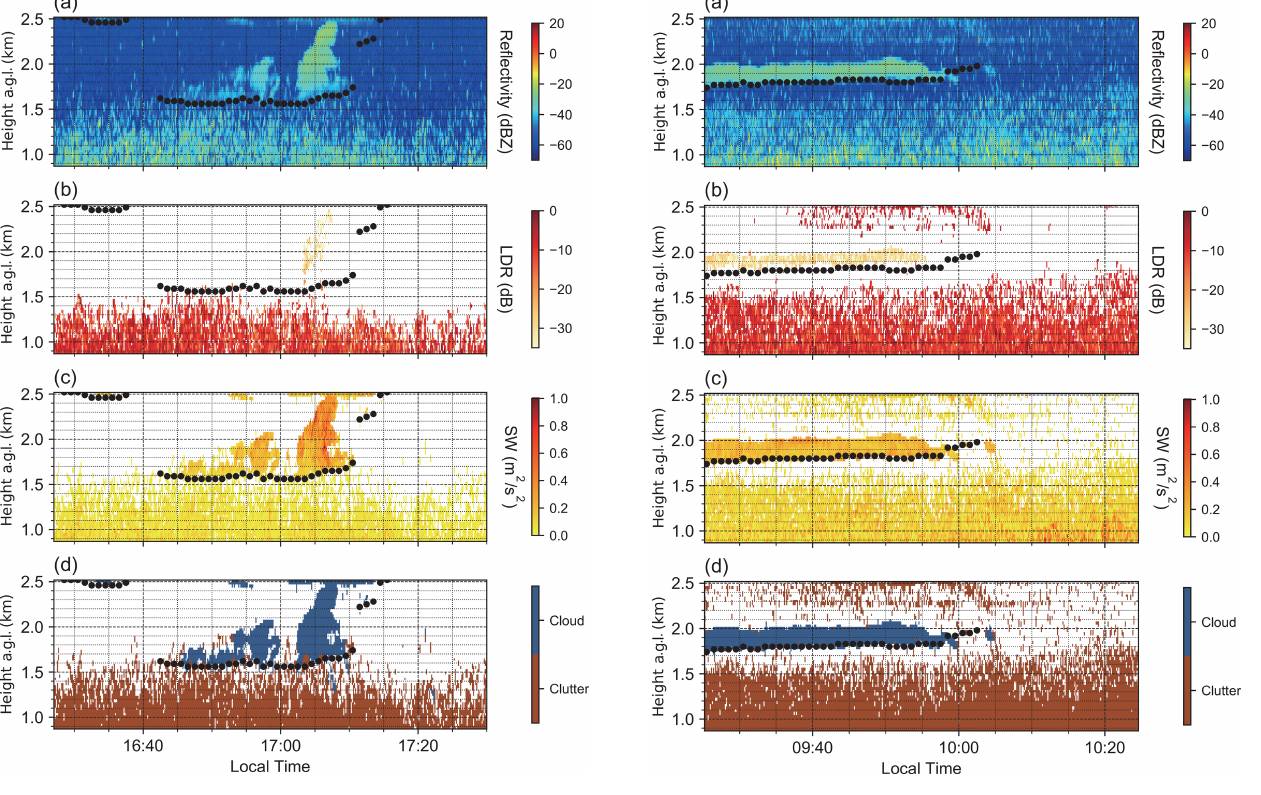
Figure 9. Same as Fig. 8 but for 09:25 to 10:25LT on 12 October